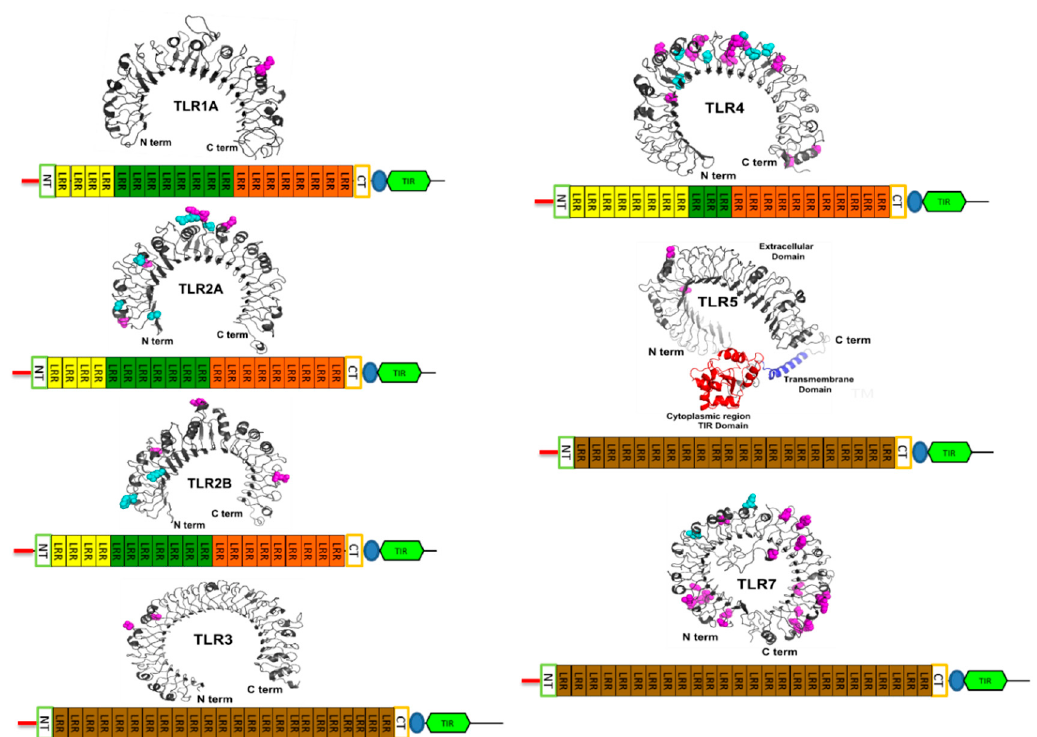
Figure 4. Scheme of TLR domain architecture for avian TLRs and the positive selected sites with PP > 0.99 in M8 which also had PP > 90 in M2a are shown in the predicted structure of respective TLRs with magenta color. The site with cyan color represents type I changes detected by TreeSAAP. The numbering of positive selected sites in as per sequences given in Supplementary File 4 Tables (For TLR1B and TLR15 structure prediction was not significant).